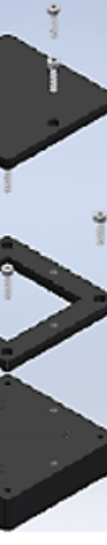
Figure 2. Computer-aided-design (CAD) magnetorheological-elastomer (MRE) mold with 3 layers: floor, middle, and top.